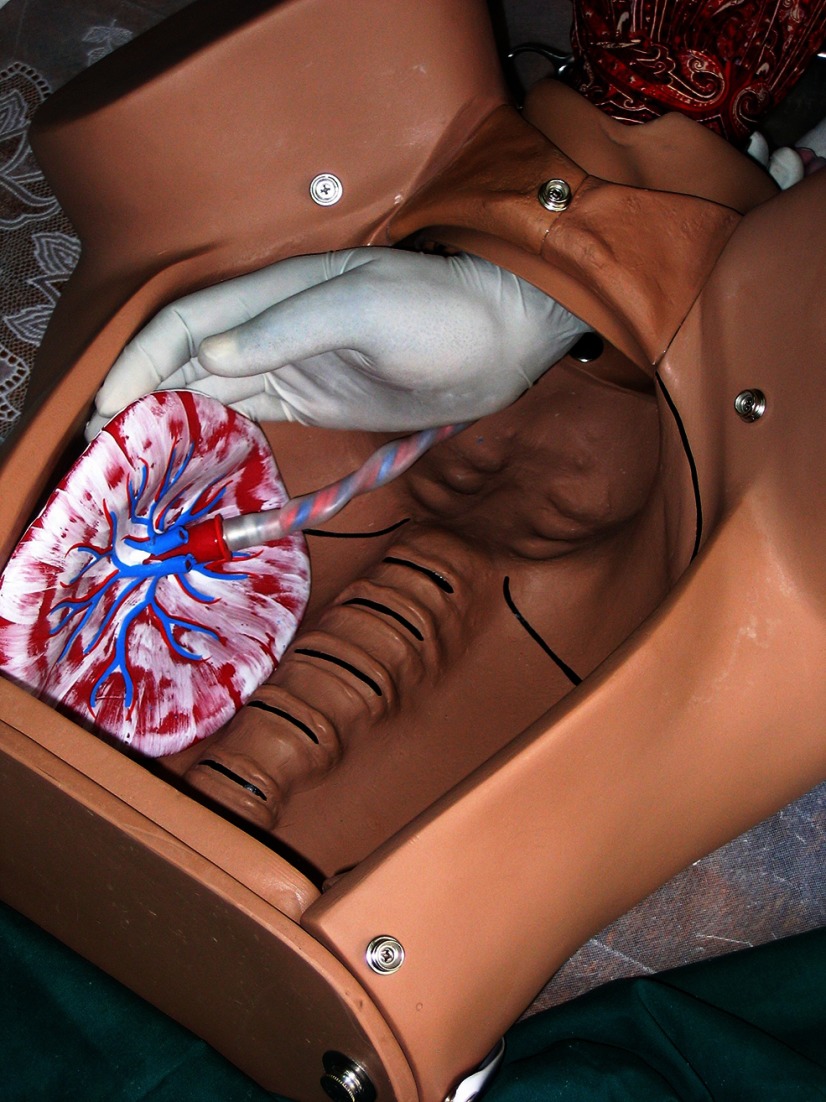
Demonstration of the Correct Hand Position for Manual Removal of a Retained Placenta on an Anatomical Model© 2006 Steven Harvey